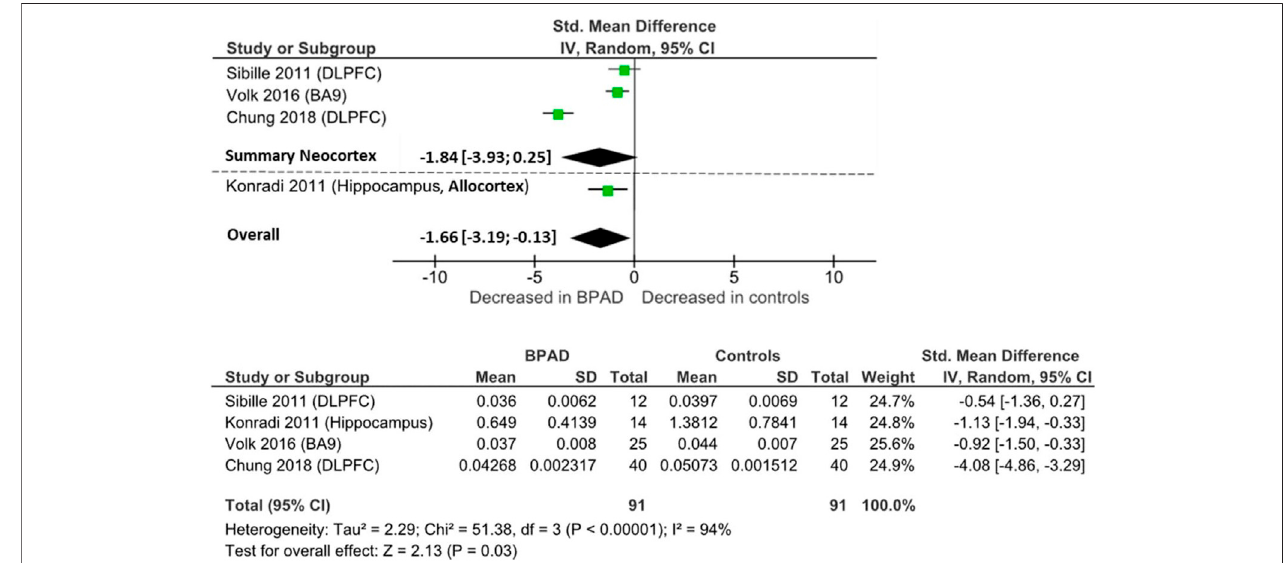
FIGURE 4 | Forest plot on PV mRNA expression: neocortical, allocortical, and overall comparison.